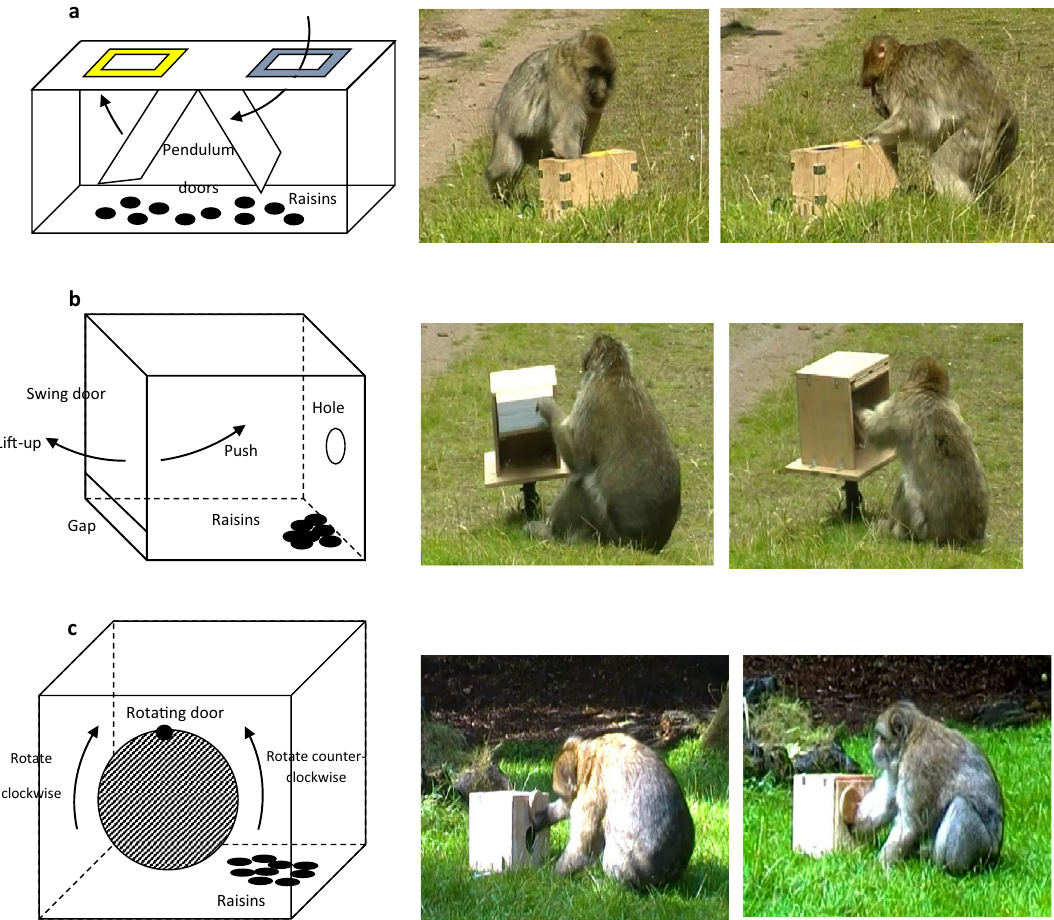
Figure 1. Diagrams (left) and photos (right) of the foraging tasks presented to a group of Barbary macaques (Macaca sylvanus) at Trentham Monkey Forest (UK). ( a ) Illustration of the blue/yellow task being used by a mid-ranking adult female (FO) retrieving rewards from the blue hole (left) and a low-ranking adult female (EF) exploring the yellow hole (right). ( b ) Illustration of the push/lift-up task being used by a high-ranking adult male (WY) using the lift-up option (left) and a low-ranking adult female (EF) using the push option (right). ( c ) Illustration of the rotating-door task being used by a high-ranking adult male (ZA) rotating the door counter- clockwise (left) and another high-ranking adult male (CC) rotating the door clockwise